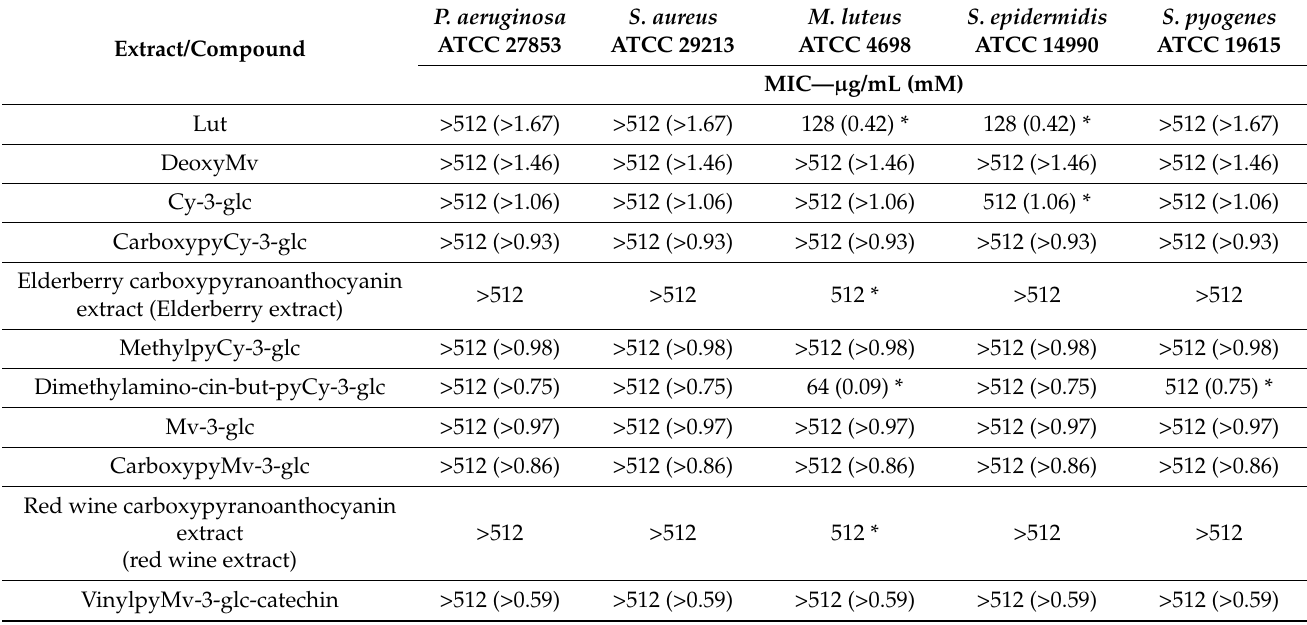
Table 2. Minimum inhibitory concentration (MIC) and minimum bactericidal concentration (MBC) values, in µ g/mL and in mM, of compounds and extracts against P. aeruginosa ATCC 27853, S. aureus ATCC 29213, M. luteus ATCC 4698, S. epidermidis ATCC 14990 and S. pyogenes ATCC